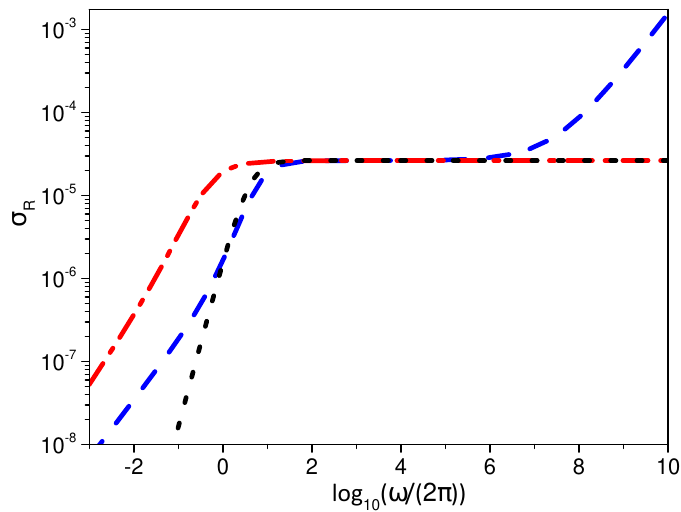
Figure 5. Electrical conductivity obtained from the impedance given by Equation (48), for different values of γ and η , with Φ ( i ω ) = p ( i ω ) + ( 1 − p )( i ω ) γ (with p = const ) and k ( i ω ) = κ ( i ω ) α (with κ = const ). The black (dotted), red (dashed-dotted), and blue (dashed) lines correspond to the cases γ = 1.0 with k ( i ω ) = 0, γ = 1.0 with k ( i ω ) (cid:54) = 0 (with α = 0.8), and γ = 0.7 (with p = 1/2) and k ( i ω ) = 0, respectively. We consider, for illustrative purposes, D = 2.0 × 10 − 9 m 2 /s, S = 3.14 × 10 − 4 m 2 , ε = 90 ε 0 ( ε 0 = 8.85 × 10 − 12 F/m), d = 1.33 × 10 − 3 m, κ = 1.11 × 10 − 6 m/s 1 − α